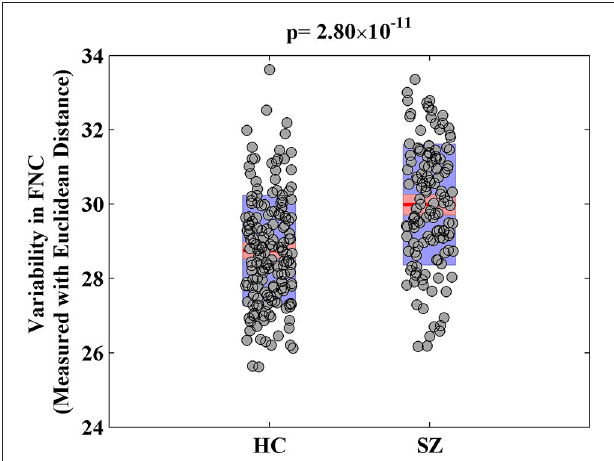
FIGURE 5 | Boxplot of variability in FNC measured with Euclidean distance.